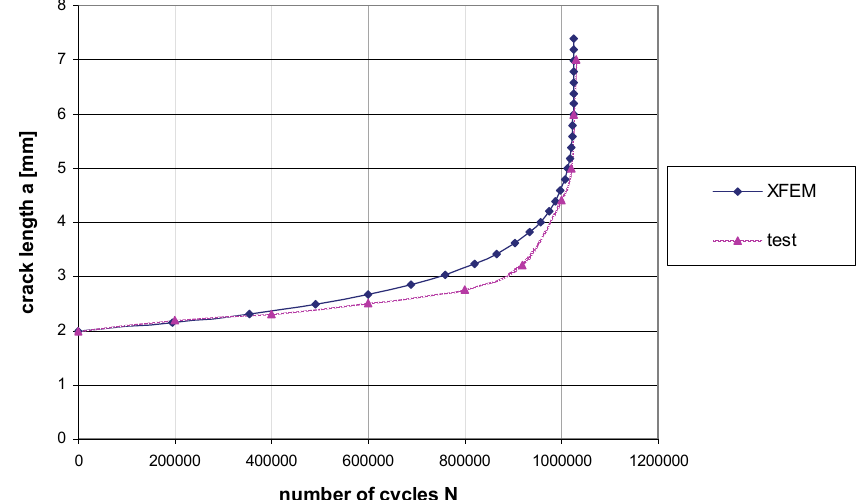
Figure 5: Comparing curves from experiment and 3D simulation.